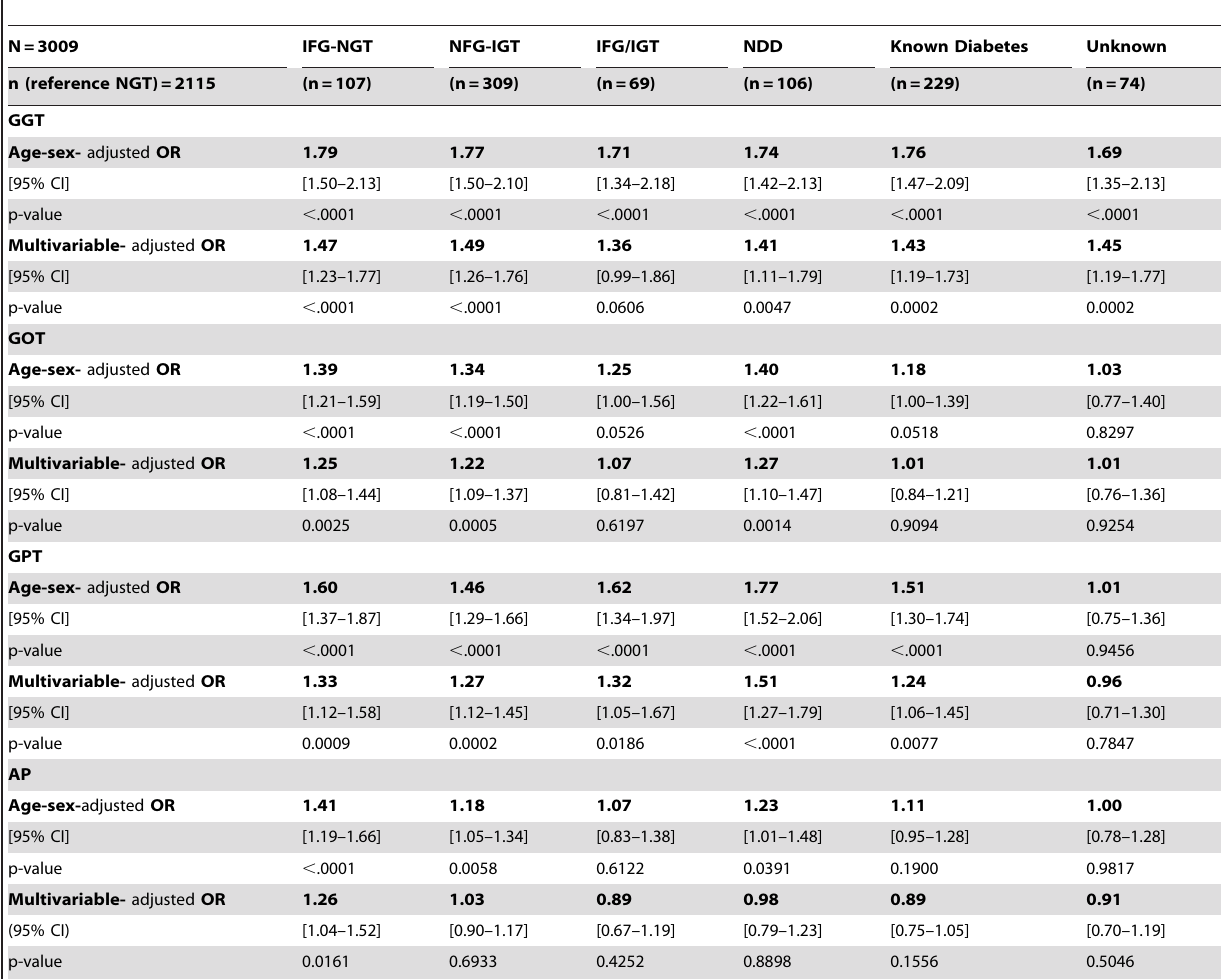
Table 2. Association of liver enzymes with glucose subgroups: Normal glucose tolerance NGT was used as reference, ORs are expressed per 1-SD increment in biomarker